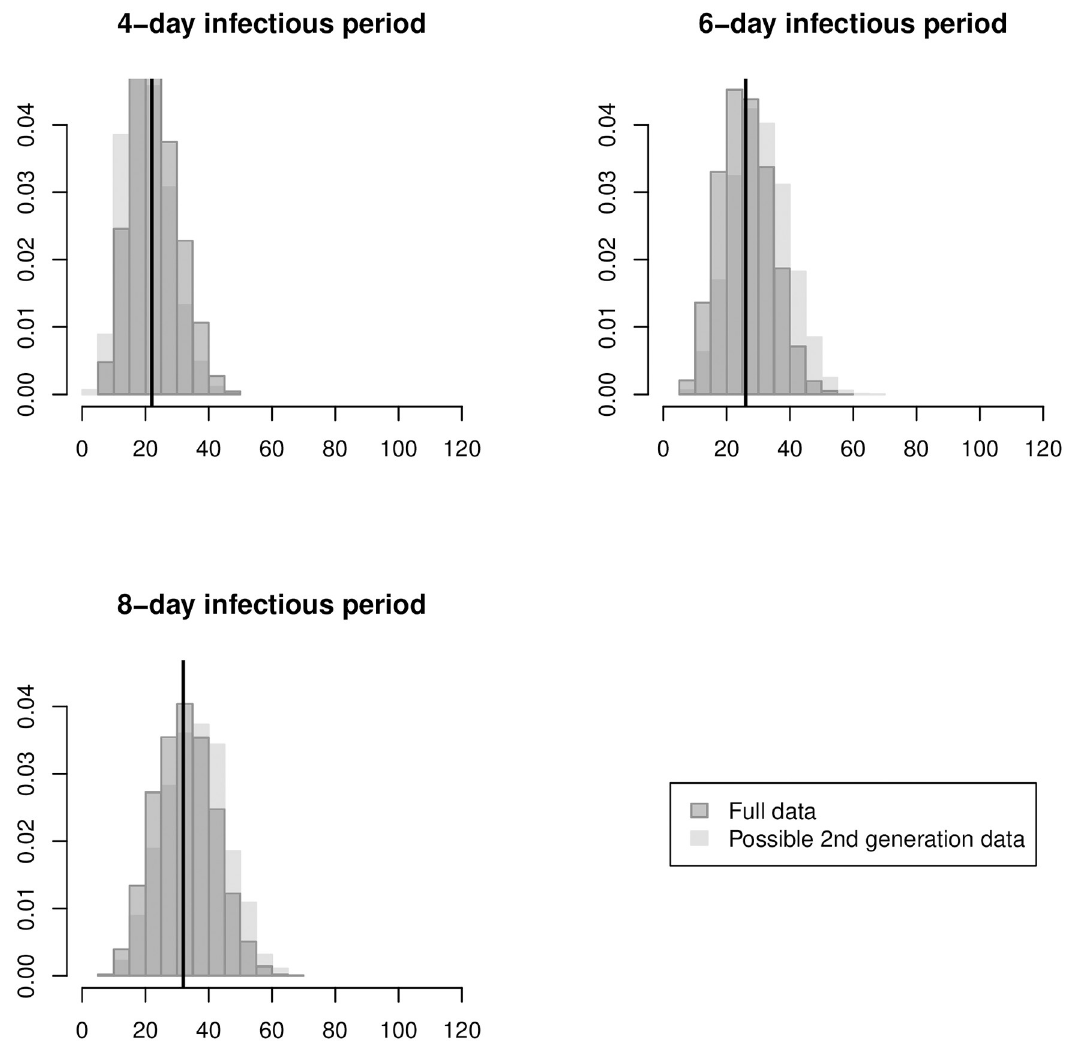
Fig 8. Histograms of simulated outbreak sizes based on pairwise exponential SAR estimates using the full data (dark gray) superimposed on the corresponding histograms from Figs 5–7 based on estimates using second generation data (light gray). For each assumed infectious period, a vertical black line shows the observed final outbreak